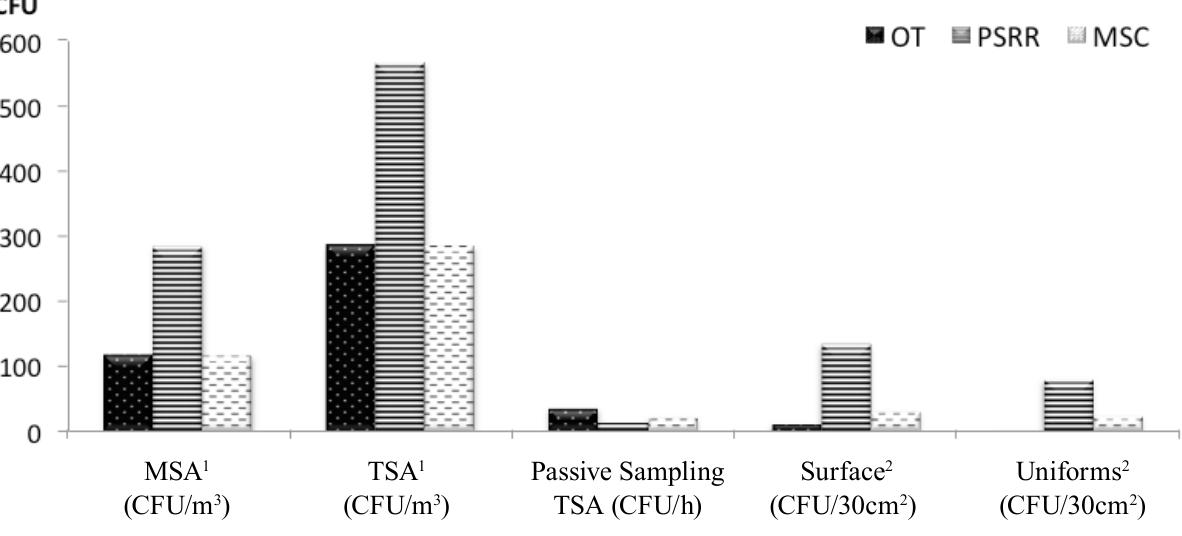
FIGURE 2 – Count of microorganisms isolated from air, surfaces and uniforms of the Hospital B. OT: operating theater; PSRR: Post-surgical rest room; MSC: material and sterilization center; MSA: mannitol salt agar; TSA: tryptic soy agar; 1: active sampling; 2: RODAC plate